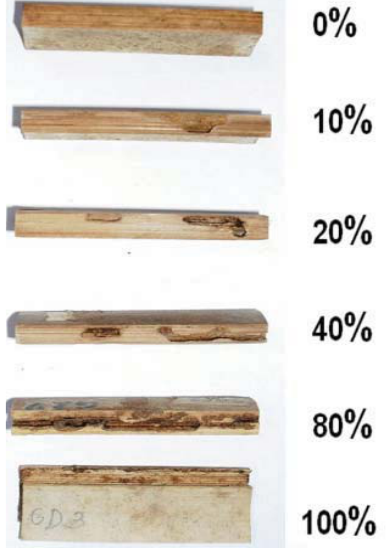
Figure 2. Visual rating of termite attack on bamboo test